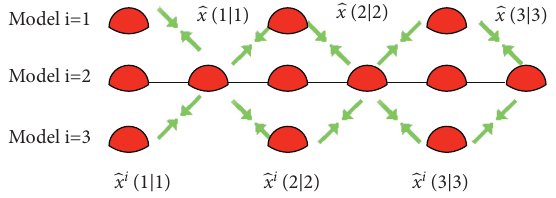
Figure 7: GPB1 algorithm structure diagram.